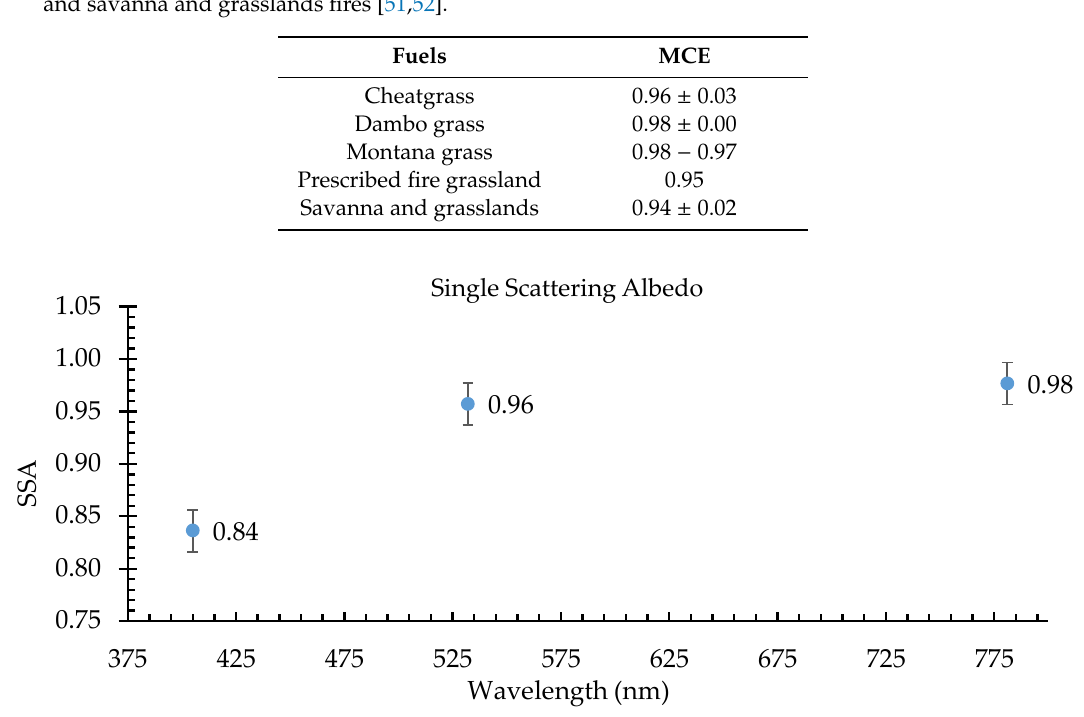
Figure 2. SSA (single scattering albedo) of cheatgrass combustion aerosols at 405 nm, 532 nm, and 781 nm. Error bars represent the standard error.